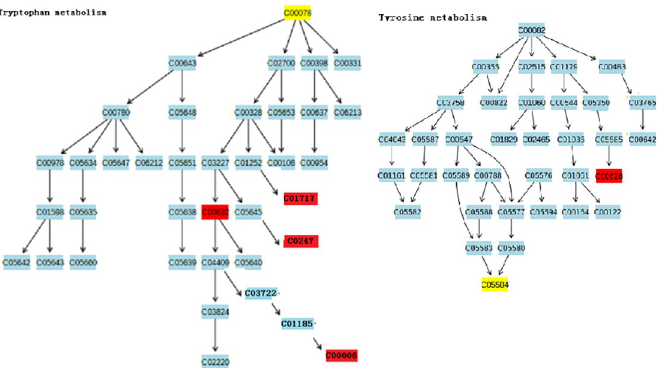
Fig 11. The view of tryptophan and tyrosine metabolism pathway. C00078 L-Tryptophan; C01717 Xanthurenate; C00632 3-Hydroxyanthranilic acid; C00247 Kynurenic acid; C00006 NADPH(Glutathione metabolism); C00628 Gentisic acid; C05584 Vanillylmandelic acid.